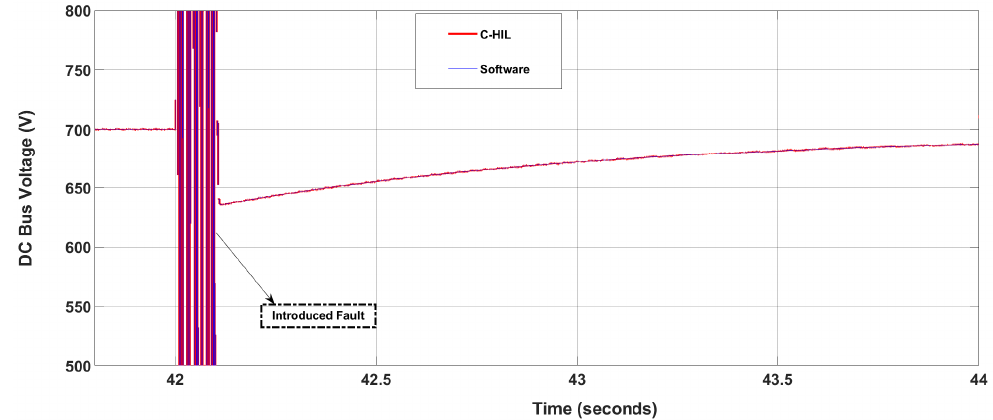
Figure 21. HIL DC bus voltage regulation under induced